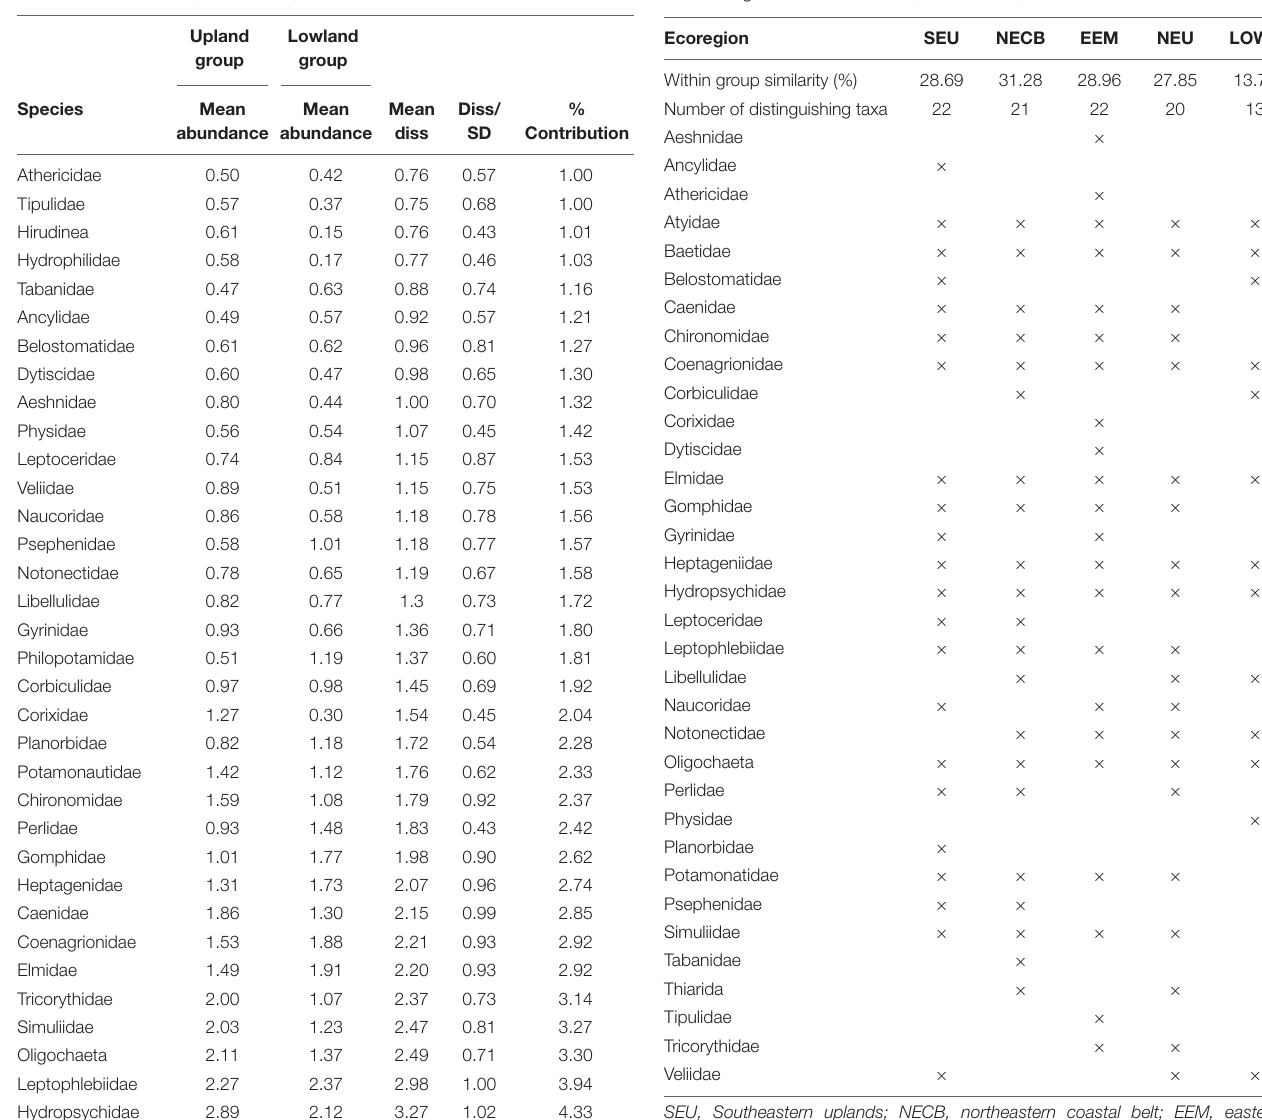
TABLE 2 | Macroinvertebrate taxa contributing within-group similarities of different river ecoregions of KwaZulu-Natal, South Africa, between 2015 and